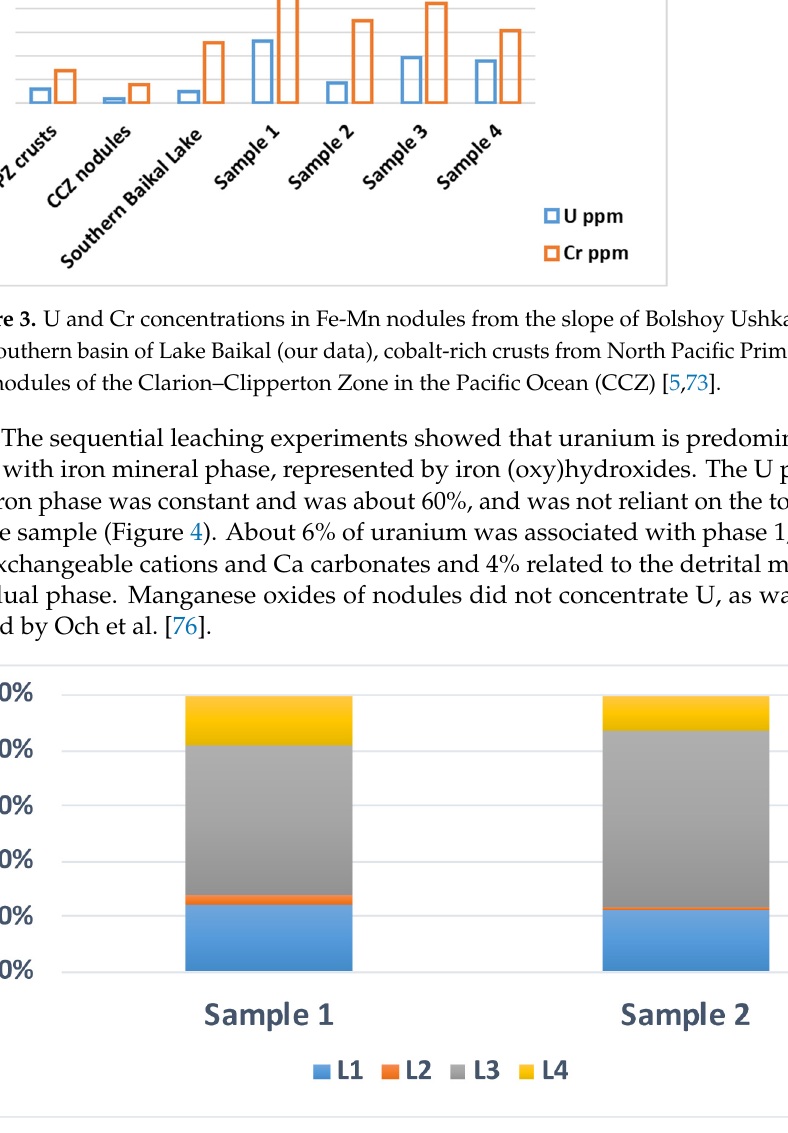
Figure 4. U distribution between four leaching steps in nodules from the Bolshoy Ushkany Island. Blank bars are analytical data with poor recovery through the leaching steps with respect to the bulk analyses, using a cutoff of 100% ± 20% recovery. Key: L1, exchangeable ions plus carbonate; L2, Mn-oxide; L3, Fe-oxyhydroxide; L4, residual fraction.